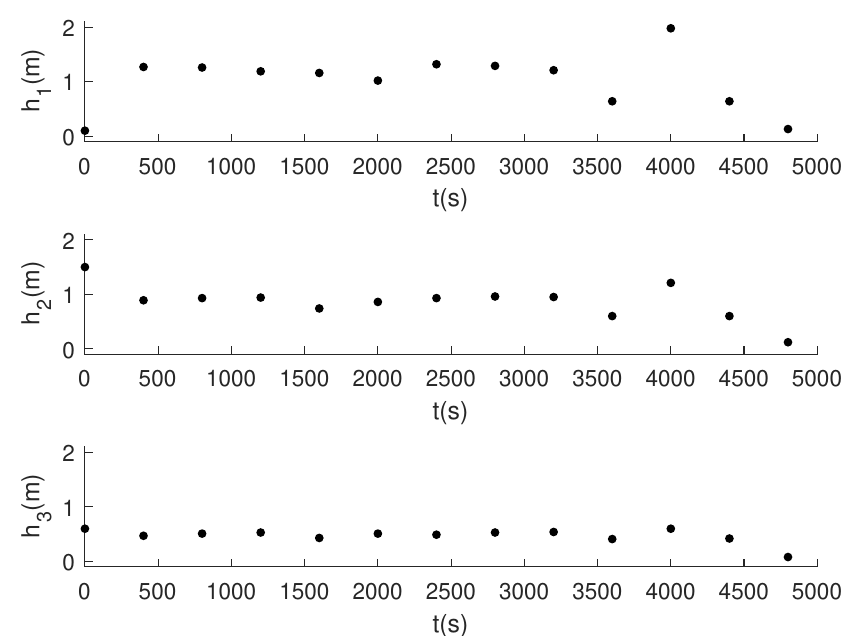
Figure 8. Three-tank system. Target heights to be achieved in open loop control. then k 1 ( t ) = d 1 ( t ) or k 2 ( t ) = d 2 ( t ) or k 3 ( t ) = d 3 ( t ) , where d 1 ( t ) is the relative distance 287 between the target height and the center of the interval h 1 ( t ) (the same for d 2 ( t ) and 288 d 3 ( t ) ). 289